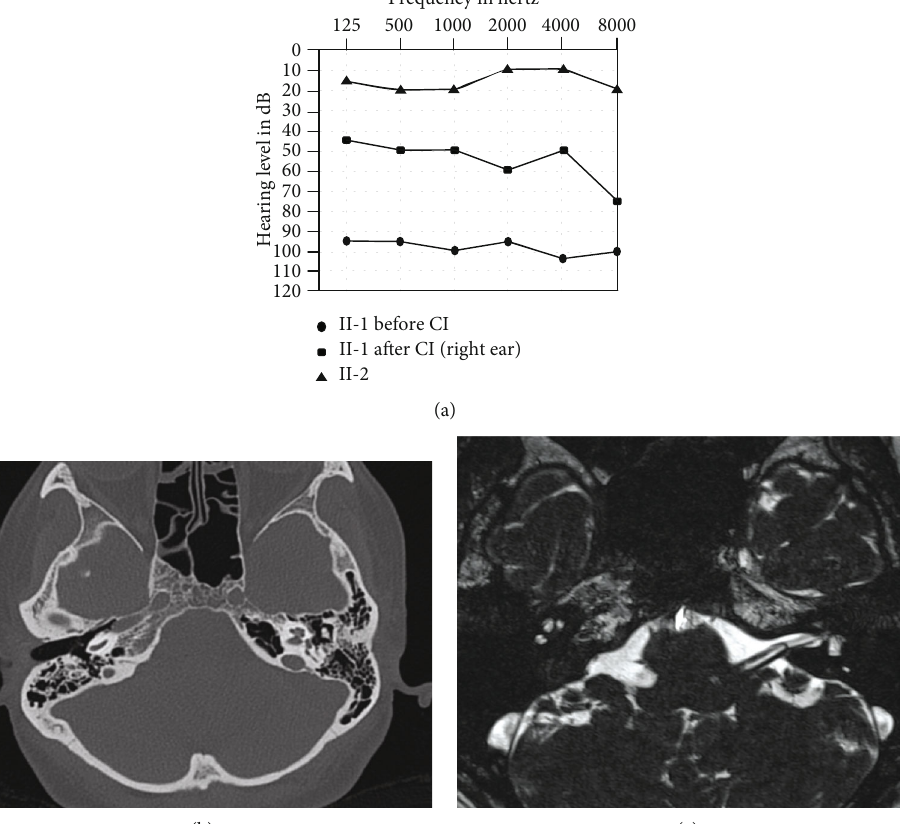
Figure 2: (a) Audiogram of the proband (II-1) before and after cochlear implantation and that of his una ff ected sister (II-2). (b) Temporal bone Computerized Tomography (CT) scan of the proband (II-1). (c) Cranial Magnetic Resonance Imaging (MRI) of the proband (II-1).